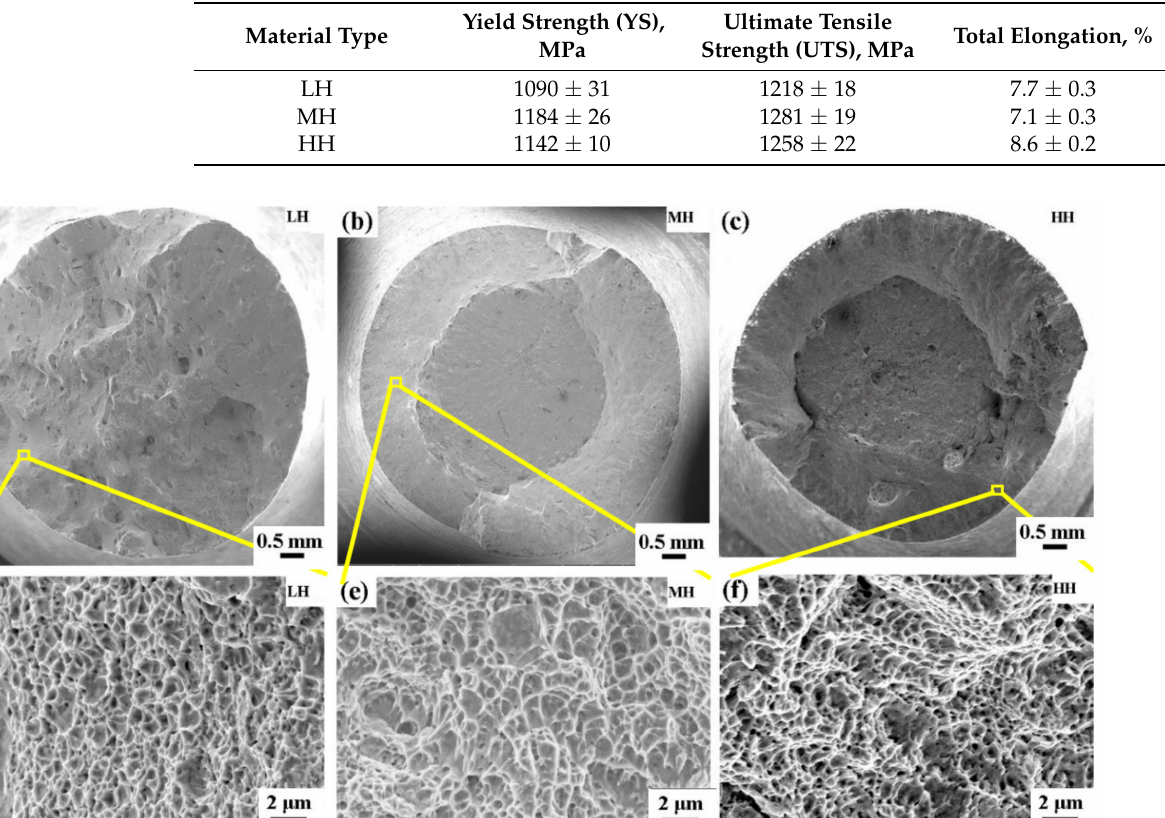
Table 2. The summarized tensile mechanical properties at 600 ◦ C.